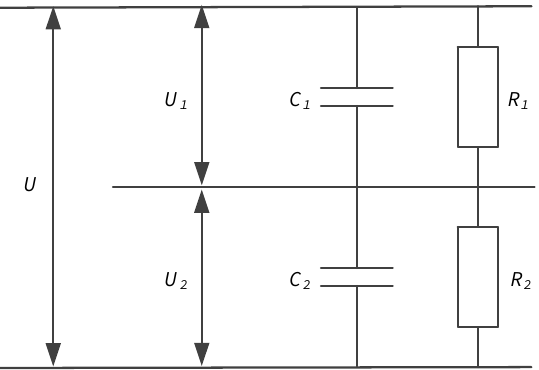
Figure 7. Physical model of oil-pressboard insulation.